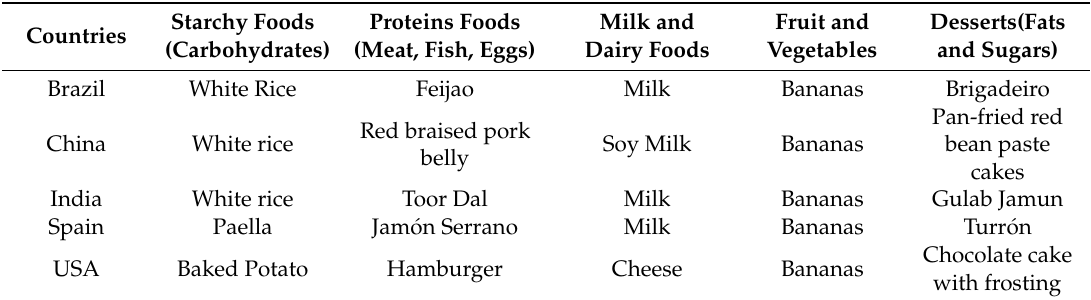
Table 1. Food items that were used for each food group in each of the five